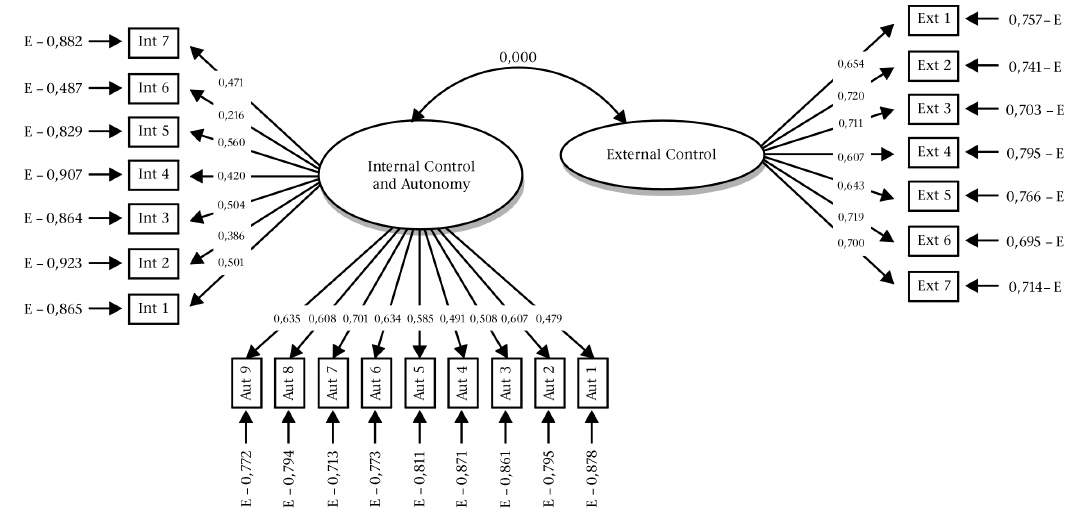
Figure 6: Standardised estimated parameters of the two-factor LCI model for the first language